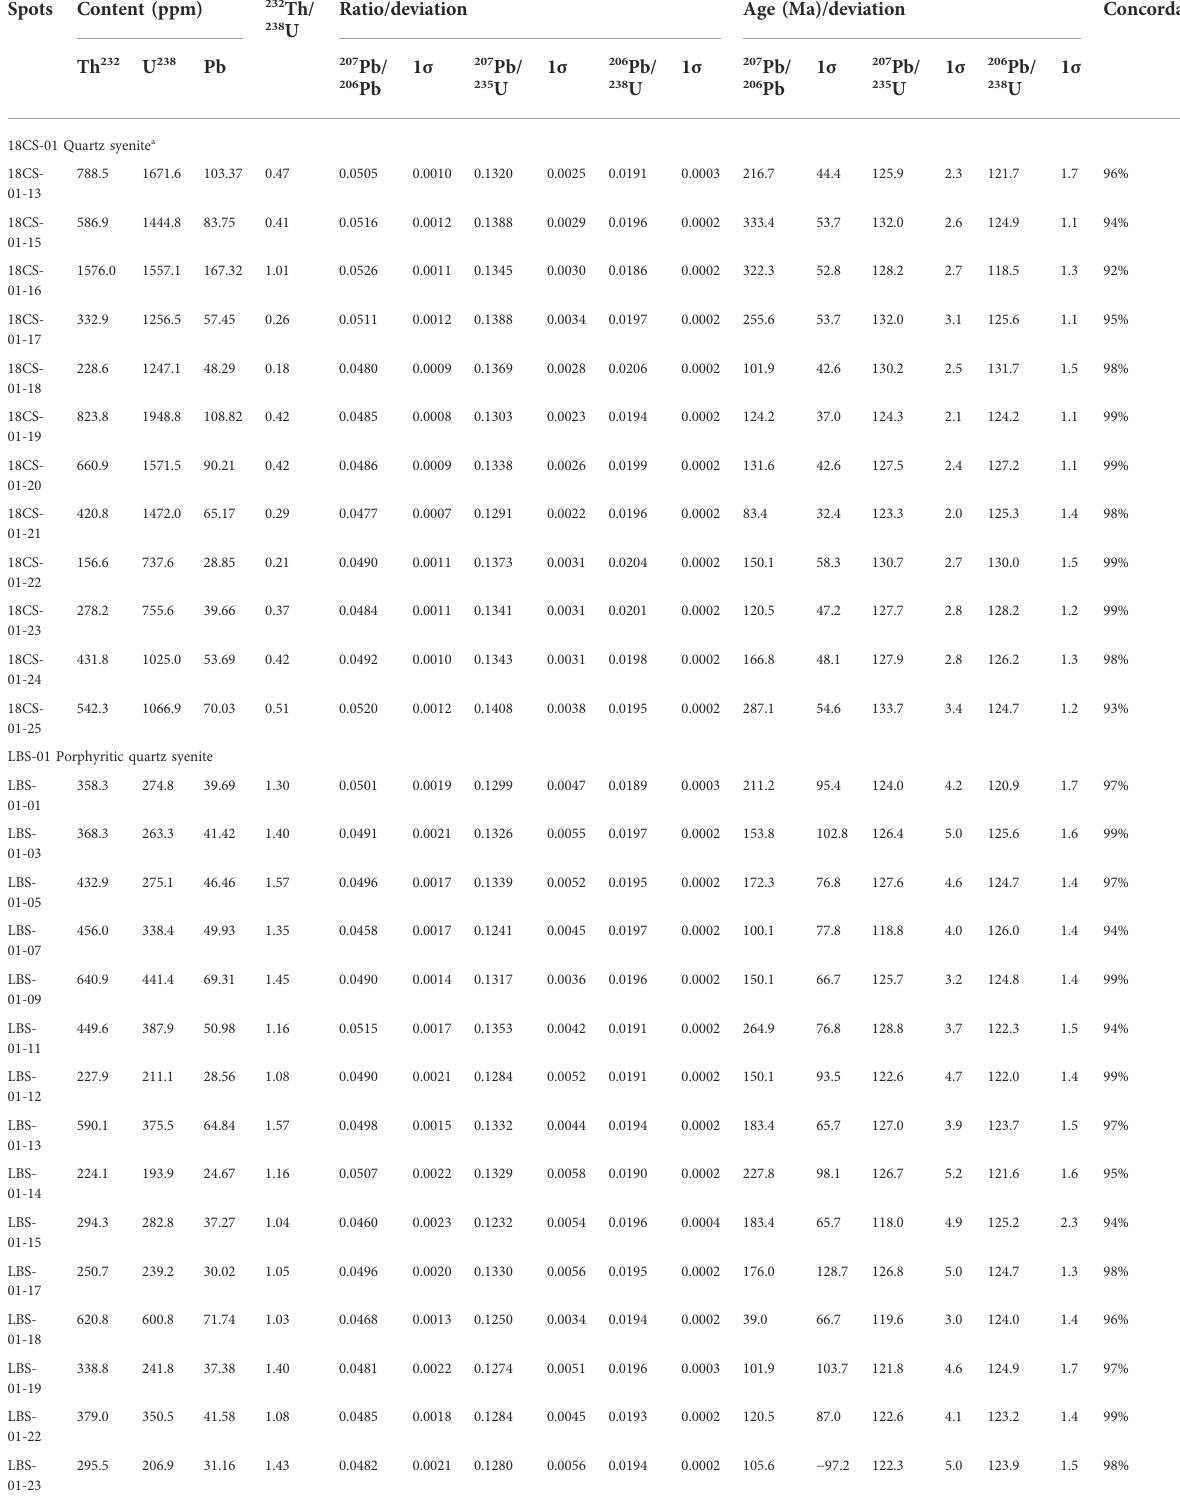
TABLE 1 LA-ICP-MS zircon U – Pb isotope analyses of the quartz syenite from Chishan and Longbaoshan complexes. Spots Content (ppm)